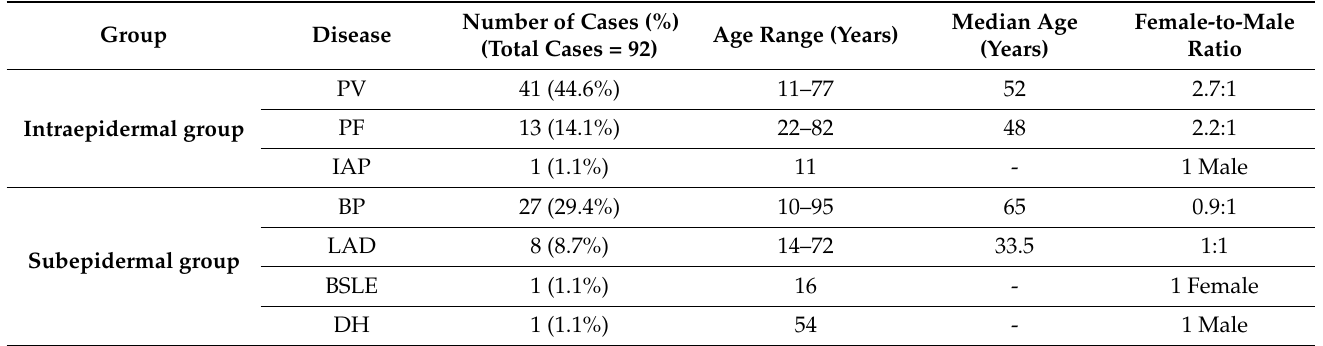
Table 3. Patient Characteristics And Prevalence Of Autoimmune Bullous